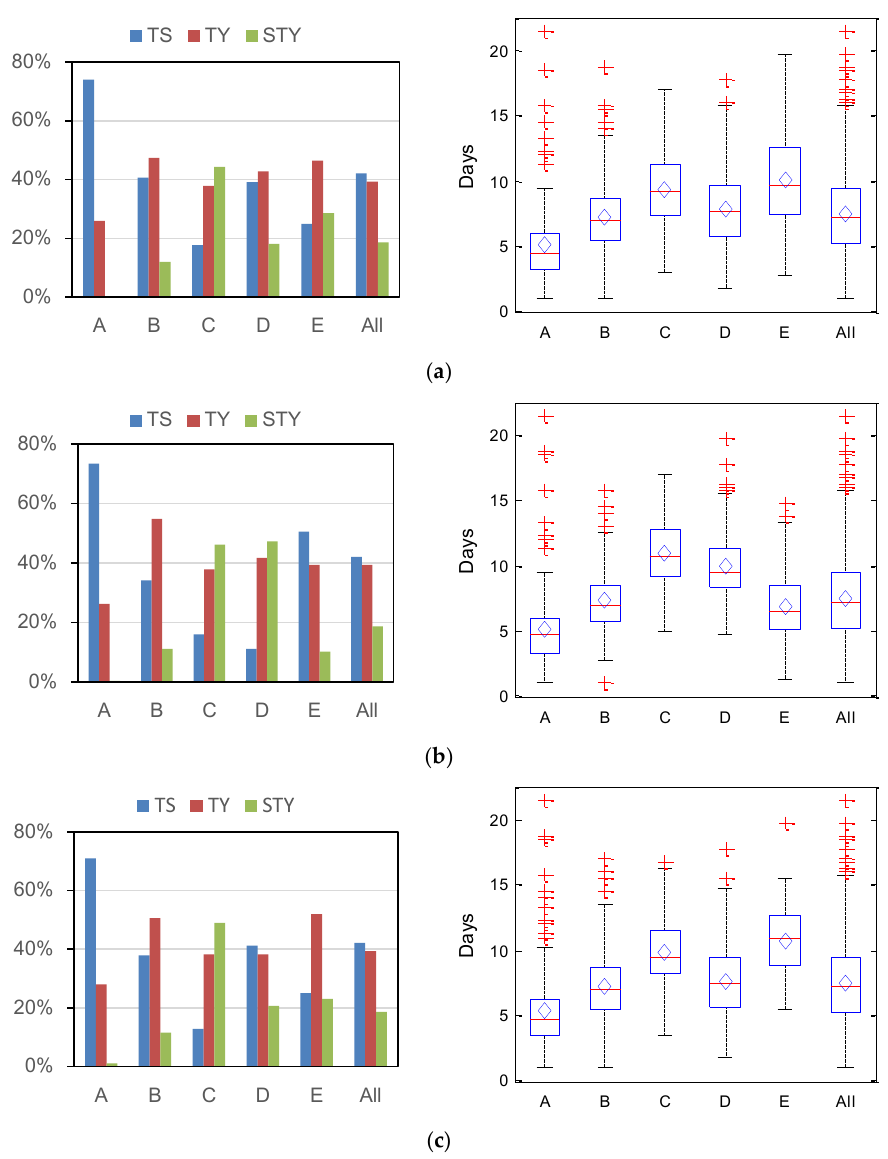
Figure 6. The statistics of intensity distribution and lifetime of TCs in different classes obtained by the different trajectory clustering methods. The histograms on the left side of the figure show the intensity distribution of TCs in different classes; the corresponding boxplot on the right side shows the lifetime statistics of TCs in the classes. The line and the diamond within the box represent the median value and the mean value of the lifetime of TCs in the class, separately. ( a ) Intensity and lifetime statistical results obtained by equal division of the trajectory method; ( b ) Intensity and lifetime statistical results obtained by mixed regression model method; ( c ) Intensity and lifetime statistical results obtained by mass moment of the trajectory method.